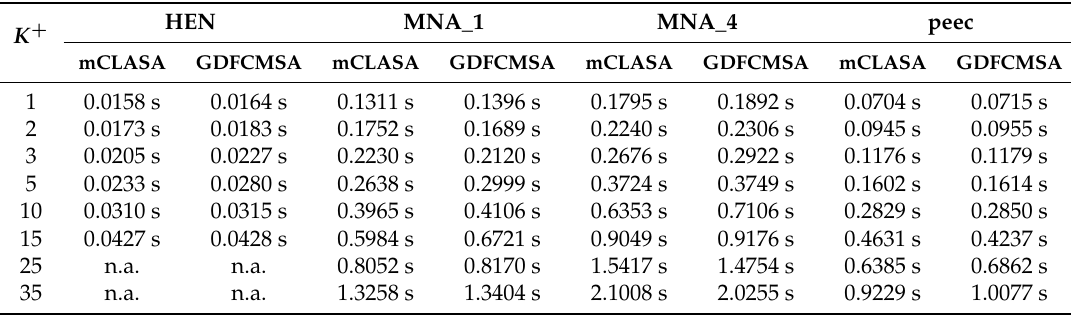
Table 2. Durations of calculations in seconds in terms of the optimal placement of K + additional sensors. The presented results are the means of 100 independent